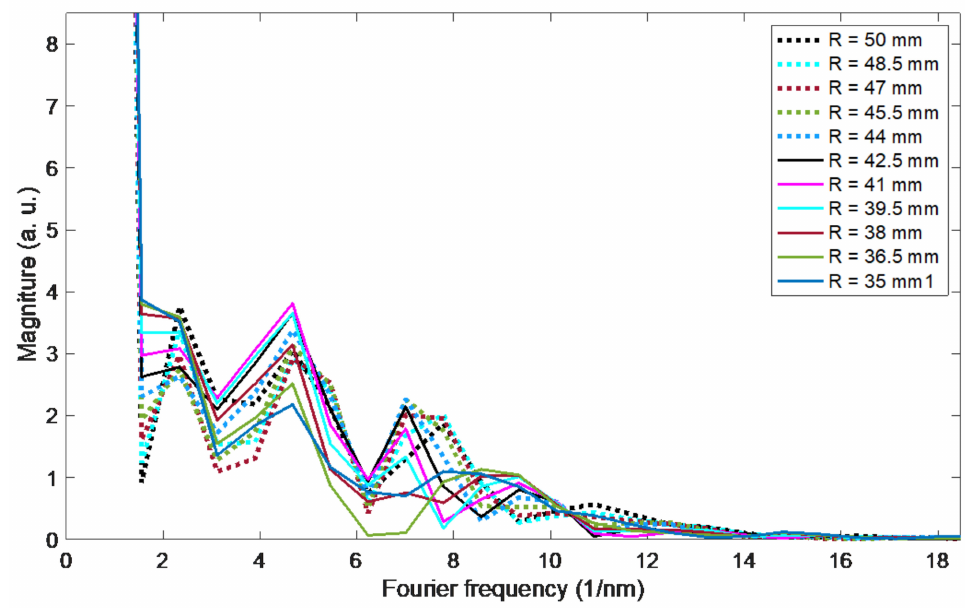
Figure 11. Fourier magnitude spectra corresponding to the optical spectra from Figure 10 for bending radii from 35 to 50 mm.